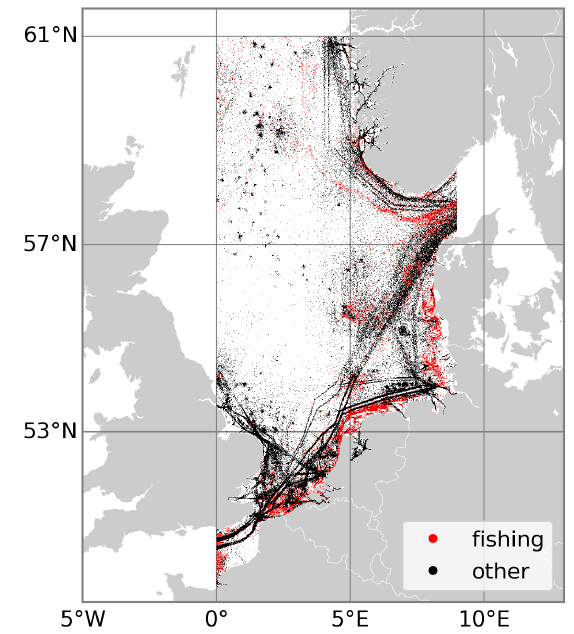
Figure 4. Distribution of AIS samples for fishing vessels (red) and non-fishing (other) vessels (black), for the period January–March